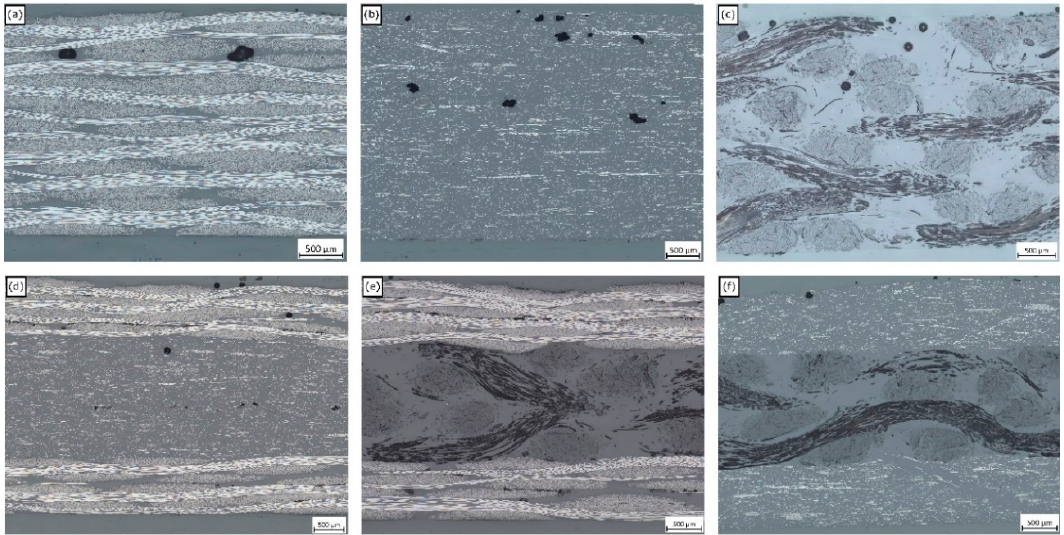
Figure 5. Optical micrographs of representative cross sections from the ( a ) virgin carbon fiber (VCF), ( b ) recycled carbon fiber (RCF), ( c ) natural fiber (NF), ( d ) VCF-RCF, ( e ) VCF-NF and ( f ) RCF-NF laminates.